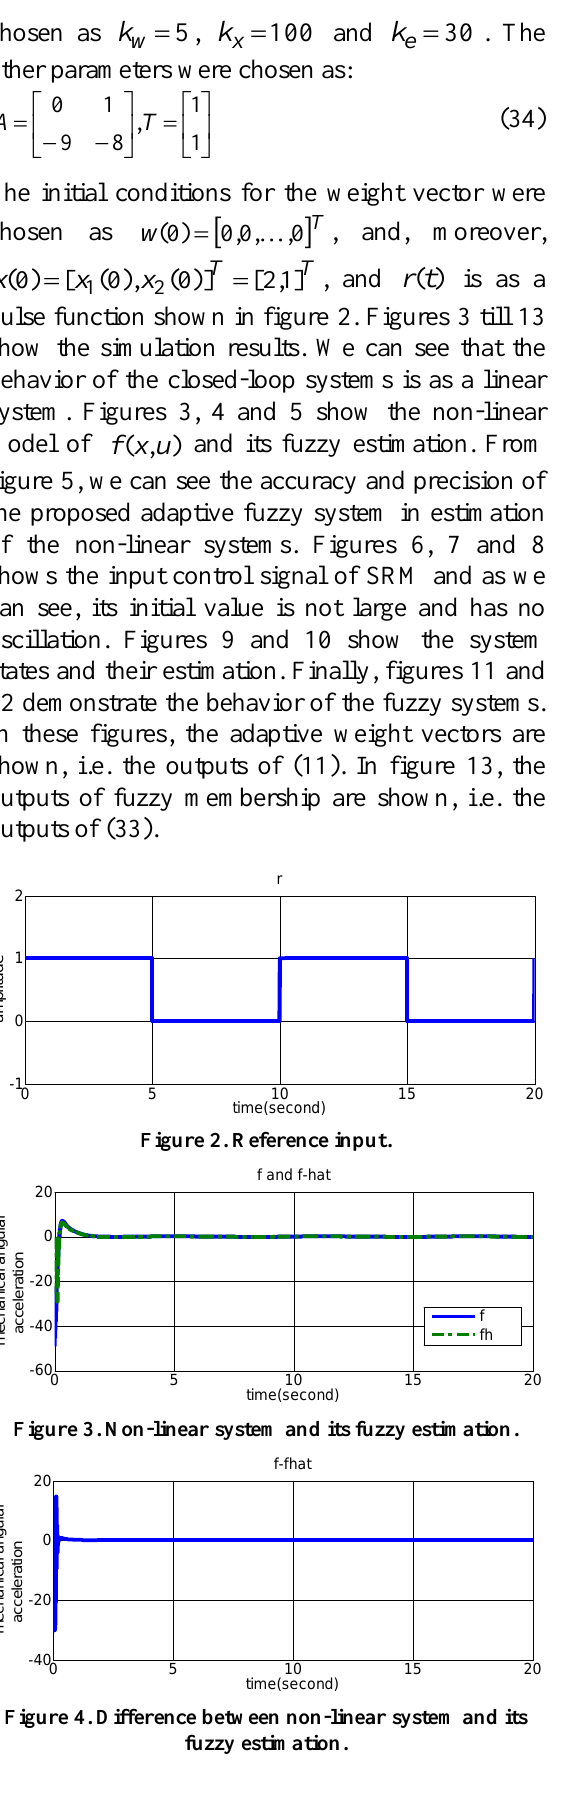
Figure 10. Second state and its